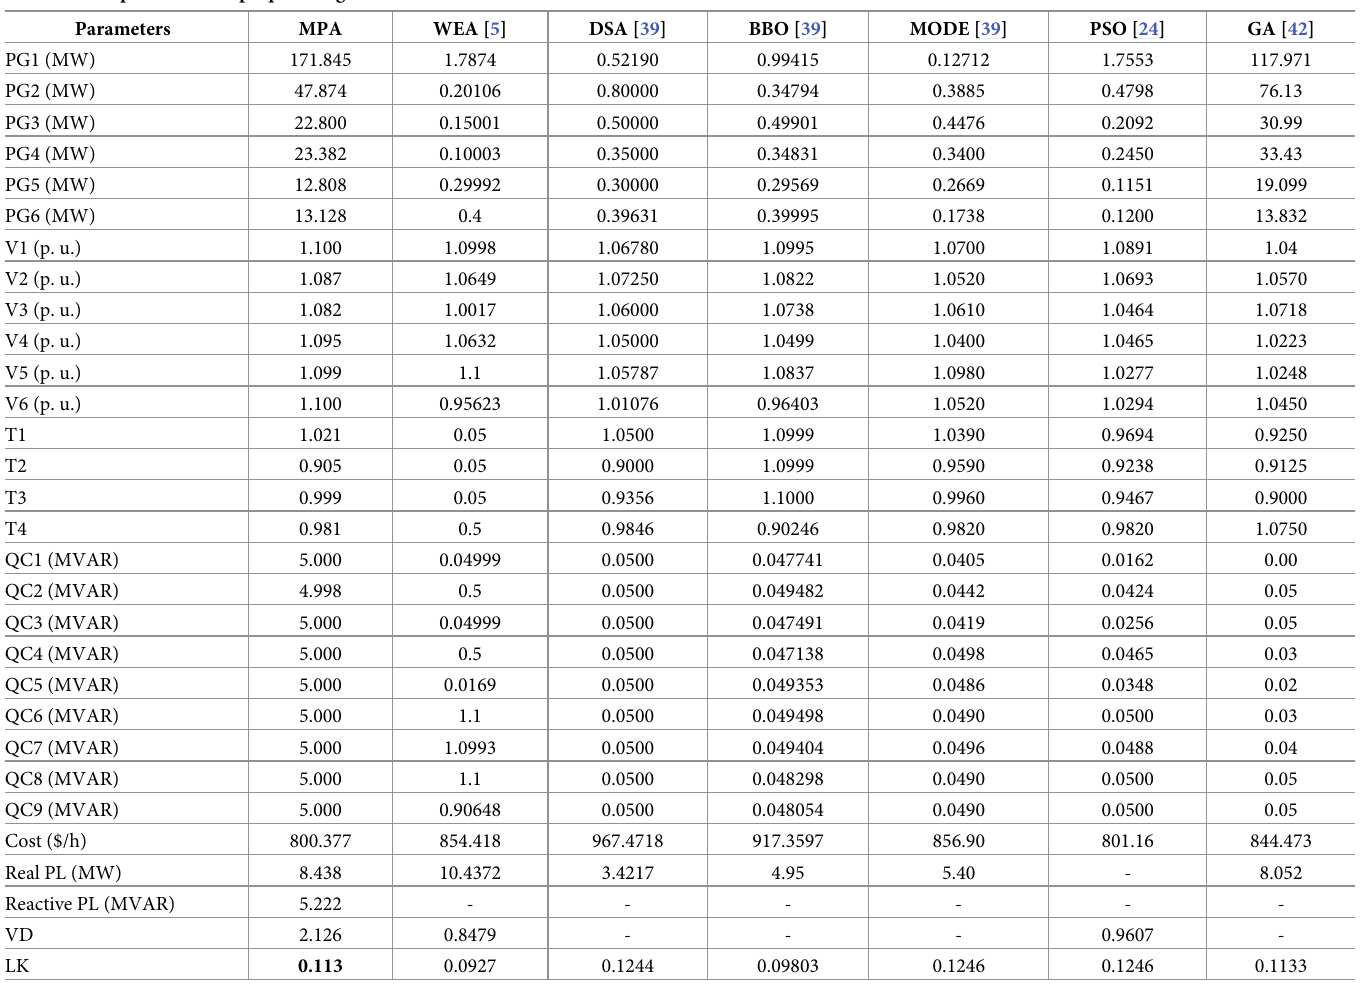
Table 6. Comparison of the proposed algorithm with other literature work for case 5. Parameters